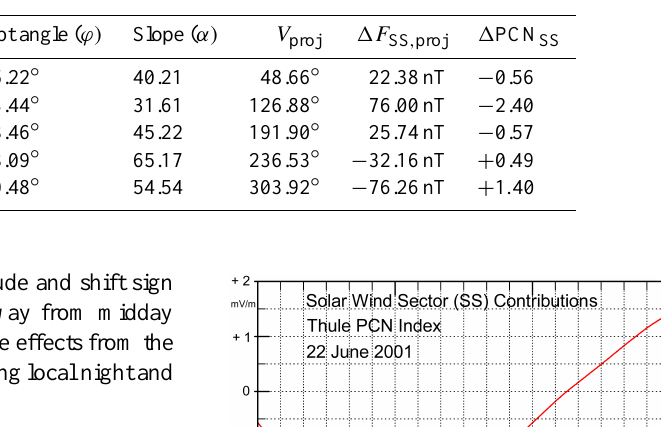
Table 1. Sector-related contributions to PCN index on 22 June 2001 according to index parameters from http://pc-index.org and (cid:49)F SS values from JT2011.